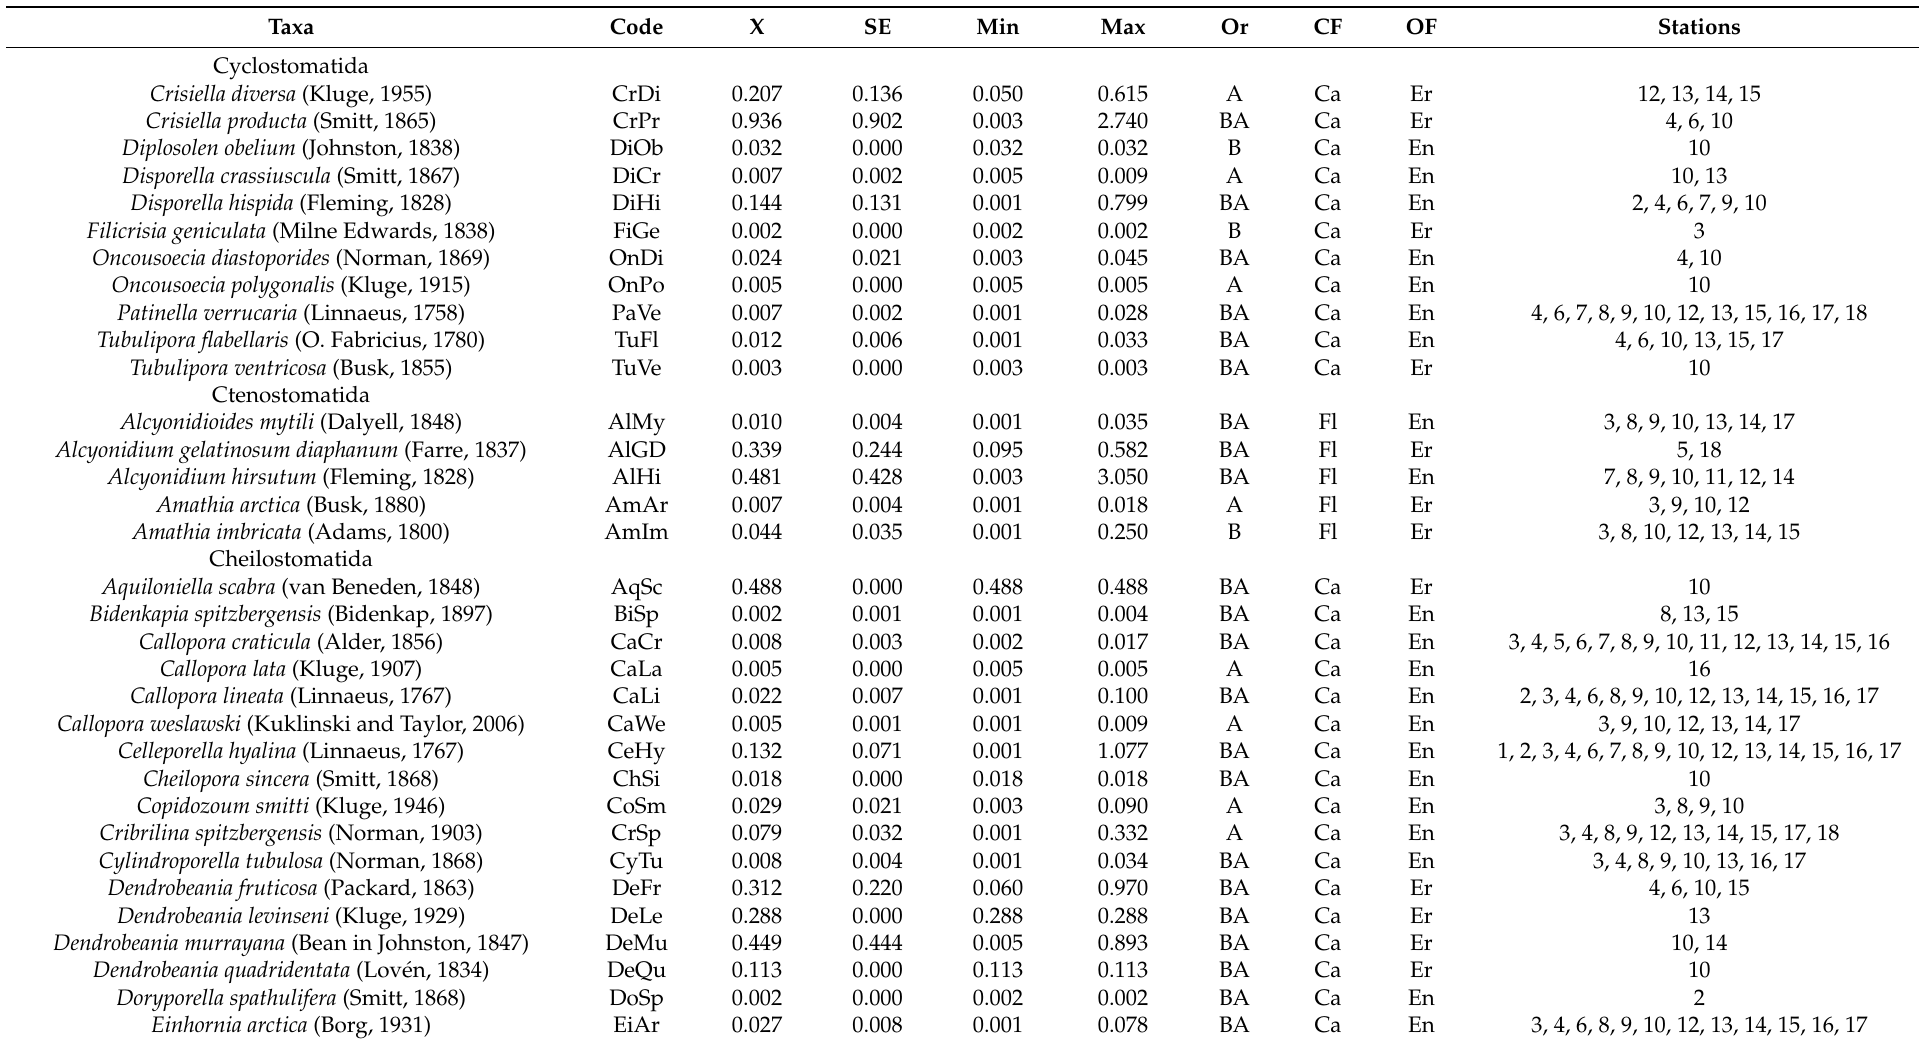
Table 1. Species composition and biomass of bryozoan species found in the intertidal and upper subtidal zones of Grønfjorden. Taxa Code